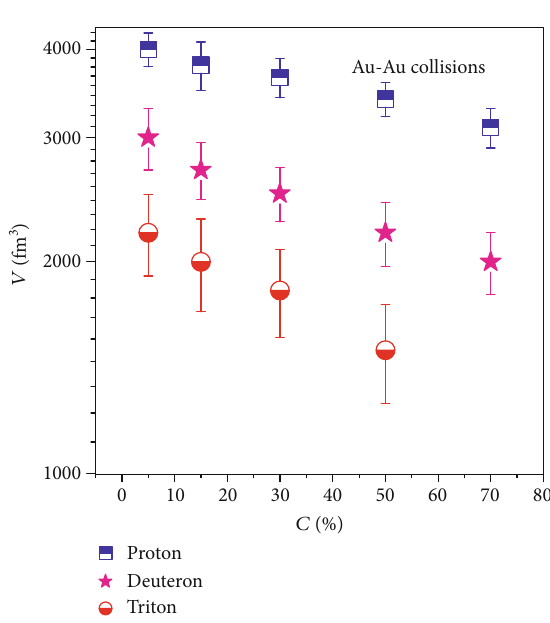
on centrality. T